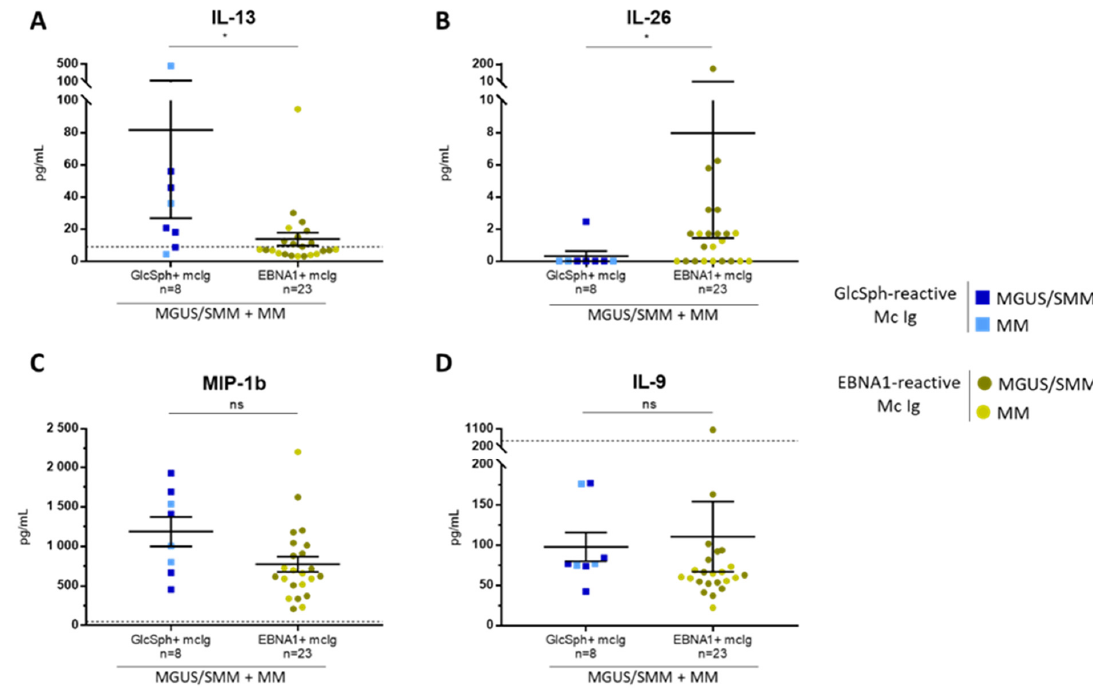
Figure 7. Di ff erences in cytokine levels according to the presence of GlcSph- or EBV EBNA-1-reactive monoclonal Ig for MGUS / SMM and MM patients. The levels of 2 cytokines, IL-13 ( A ) and IL-26 ( B ) were significantly di ff erent depending on the antigen specificity of the monoclonal Ig, whereas the levels of MIP-1 β ( C ) and IL-9 ( D ) were not. Note that each figure has a di ff erent scale; bars indicate means ± SEM. GlcSph + : with GlcSph-reactive monoclonal (mc) IgG; EBNA-1 + : with EBV EBNA-1-reactive mc IgG. ( (cid:4) ) MGUS / SMM and ( (cid:4) ) MM patients with GlcSph-reactive mc IgG; ( patients with an EBNA-1-reactive mc IgG. (*) p < 0.05, Mann–Whitney t -test. The dotted line represents the highest normal value observed in healthy donors. NS: not